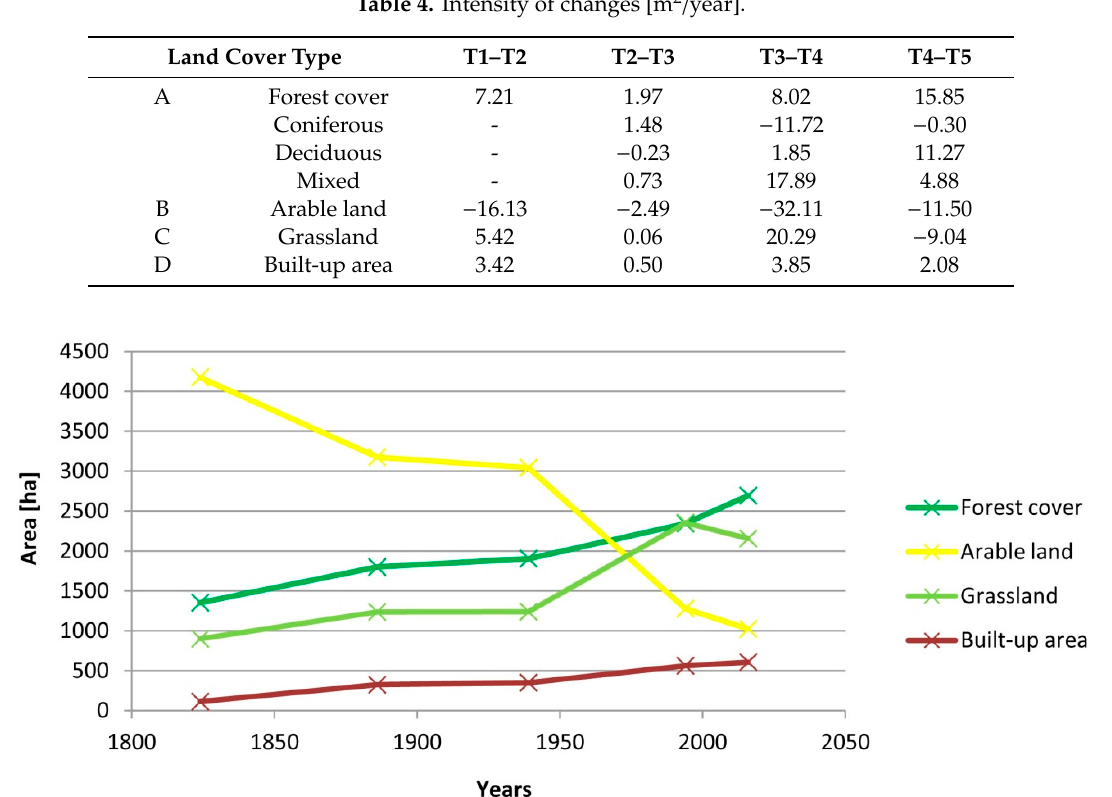
Table 4. Intensity of changes [m 2 /year].